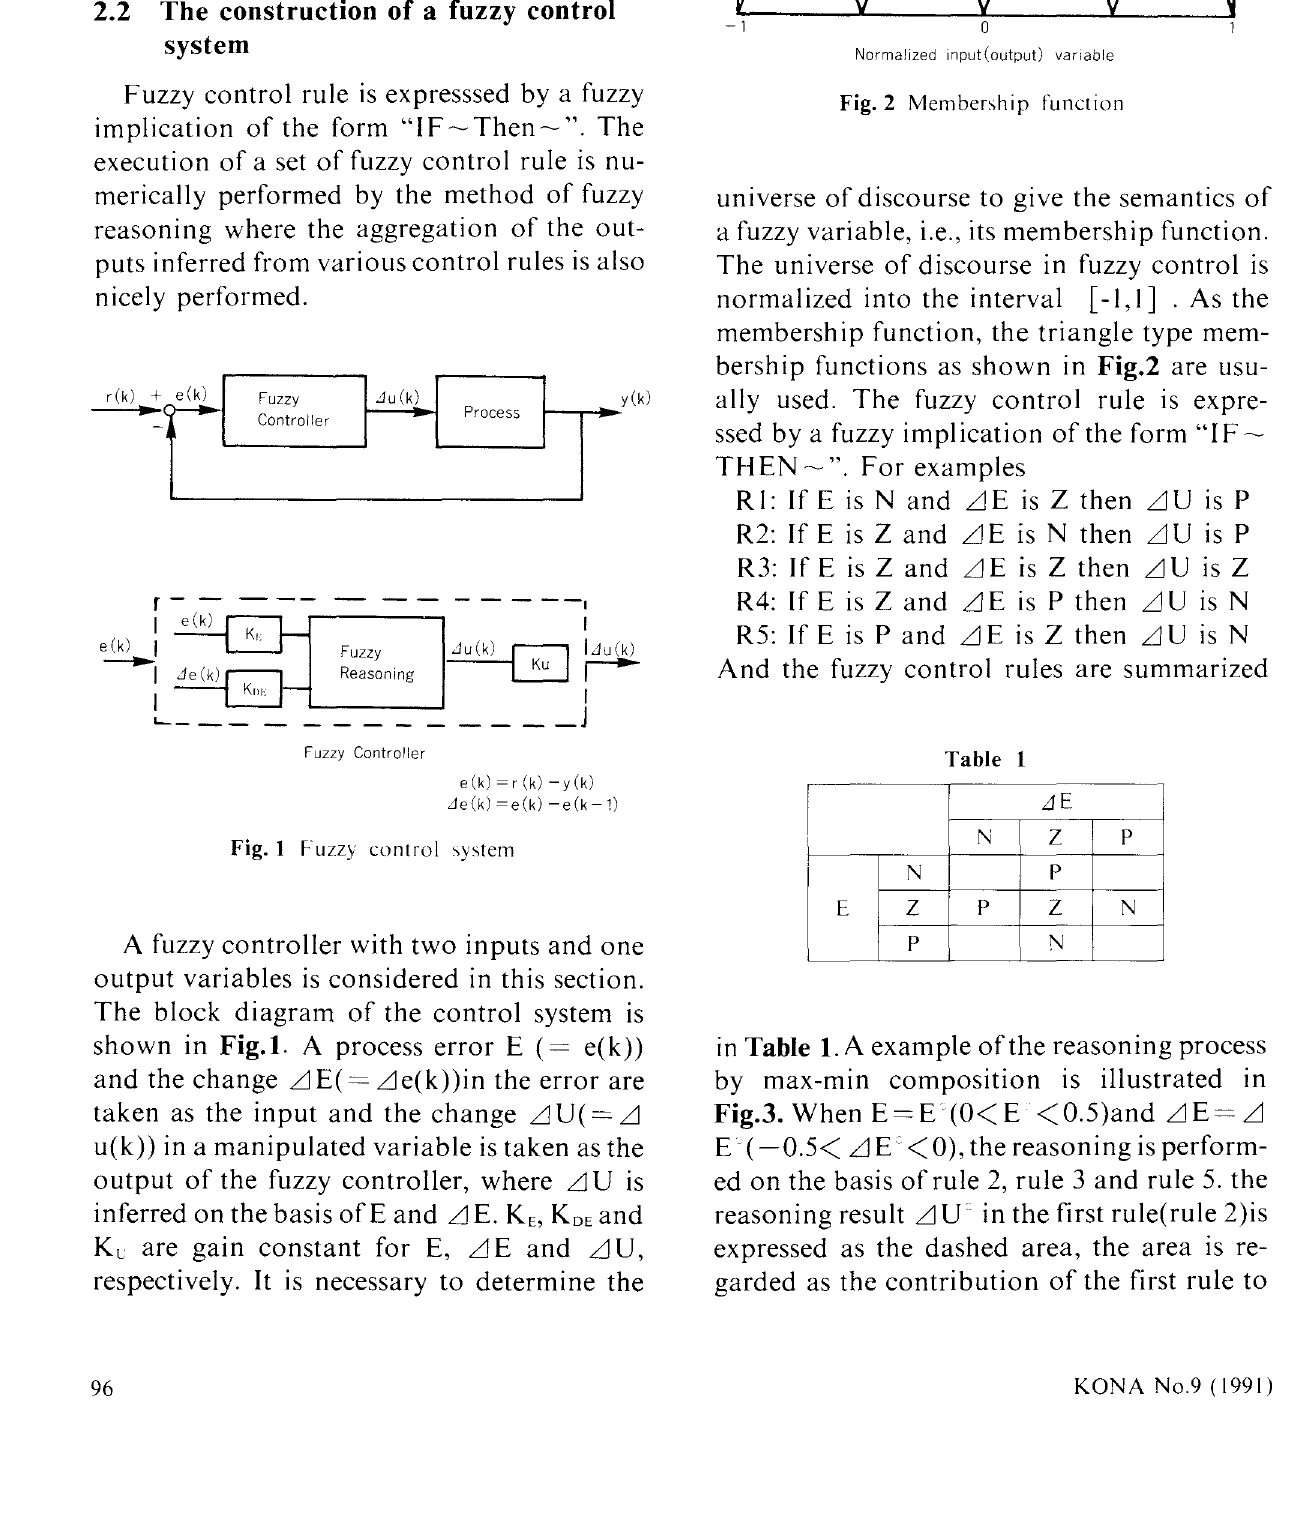
Fig. 2 Member-.,hip function